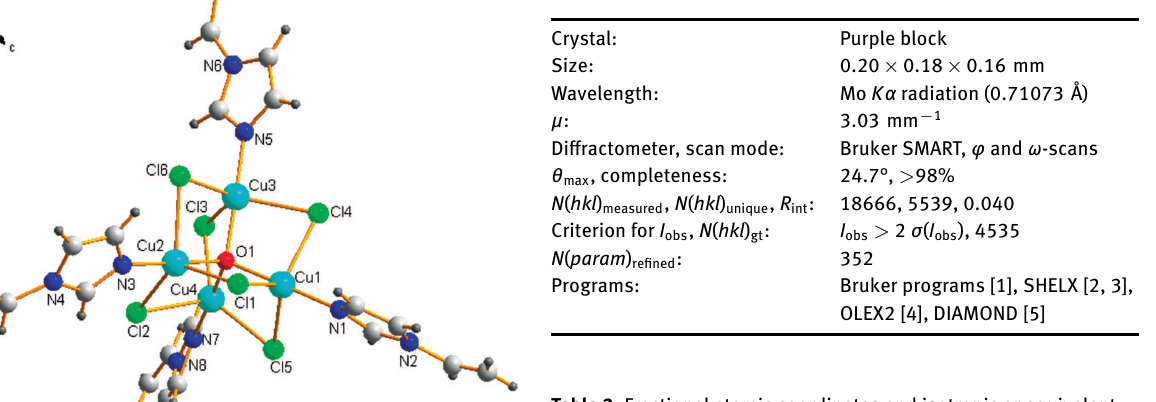
Table 1: Data collection and handling.